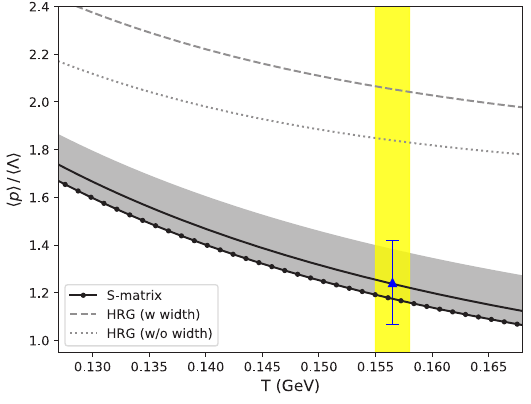
Figure 1. Proton to Λ + Σ 0 -baryons yield ratio is shown as a function of temperature. The predictions from the S-matrix scheme and from the HRG scheme (with and without width) are presented as line, dashed line and dotted line respectively. The blue solid triangle represents the experimental value measured by the ALICE collaboration for the most central Pb-Pb collisions (at 2 . 76